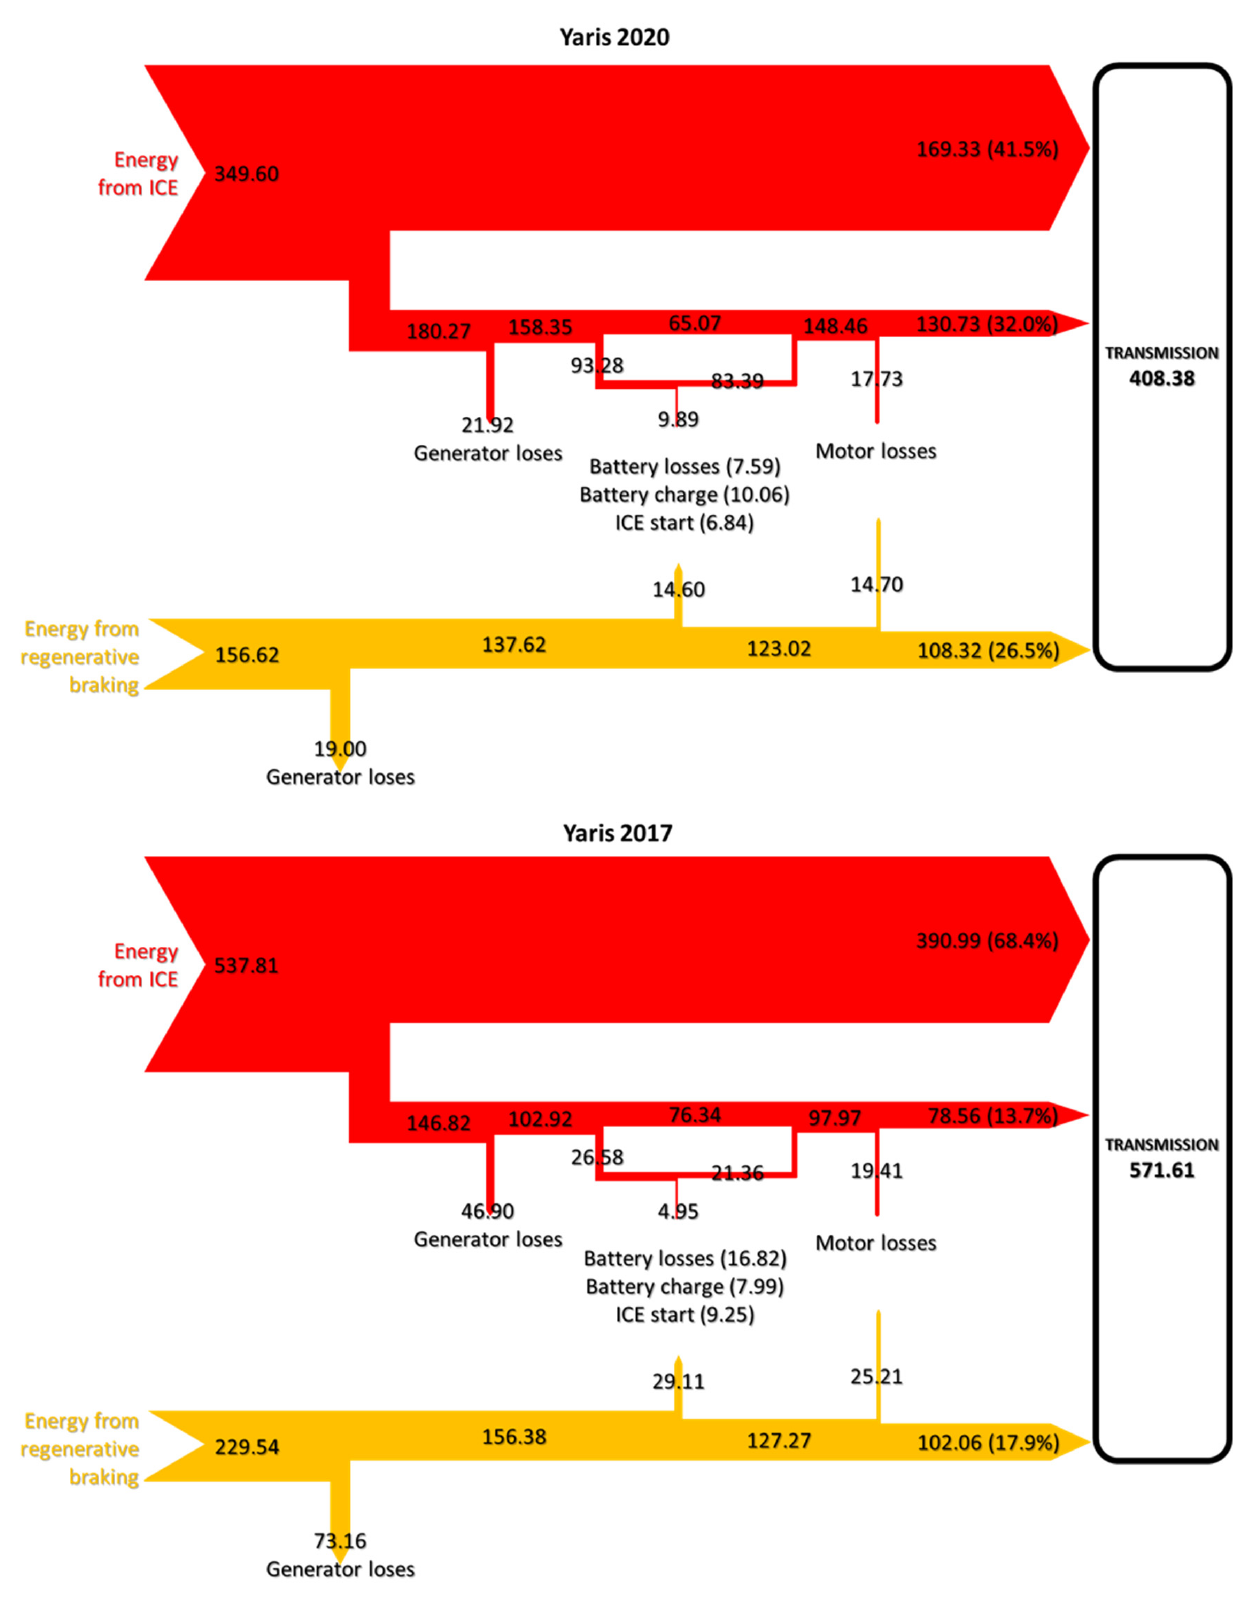
Figure 17. The energy flow of hybrid system Yaris 2020 and 2017.